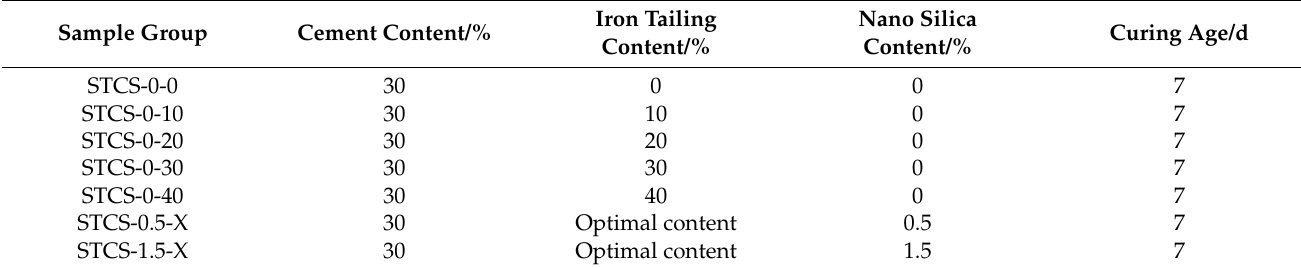
Table 5. Test scheme for STCS.